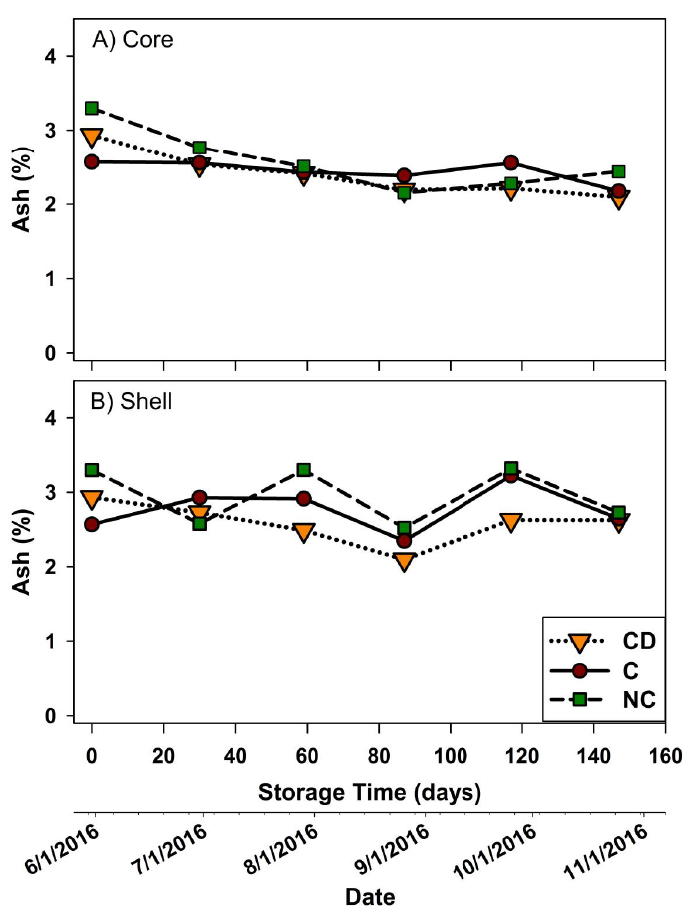
Figure 7. Variation of the ash content of willow and poplar wood chips stored for five months in piles with three di ff erent treatments (NC—no cover on pile; C—covered pile; CD—covered pile with dome ventilation); A) samples from the core; B) samples from the shell.